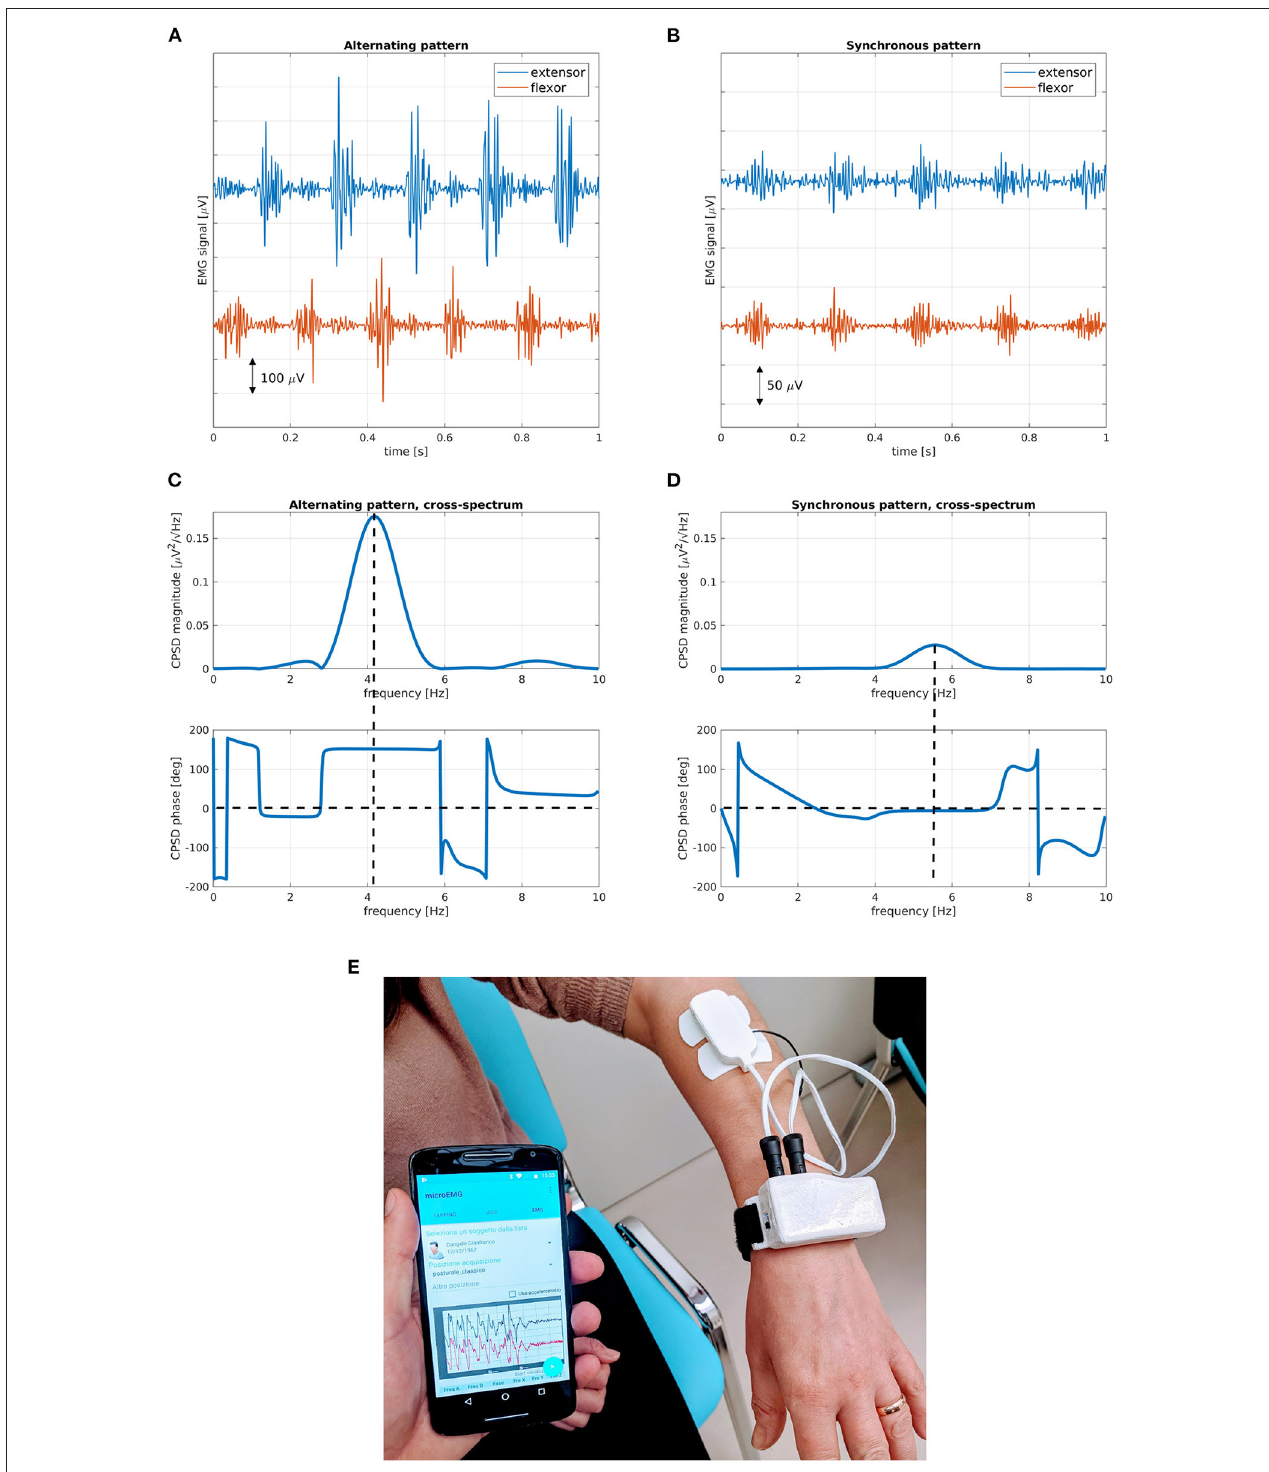
FIGURE 1 | Electrophysiological and spectral characteristics of tremor patterns. Muscle bursts for (A) alternating and (B) synchronous tremor patterns; magnitude and phase cross-spectral diagrams for (C) alternating and (D) synchronous tremor patterns. (E) Wrist-worn device, with EMG plates and mobile app for the characterization of tremor patterns. Alternating bursts of antagonist muscles show a marked phase difference at peak tremor frequency, while synchronous bursts have a small phase difference at peak tremor frequency. In alternating tremors, peak amplitude is usually higher and average frequency is lower than in synchronous tremors. EMG, electromyography; CPSD, cross power spectral